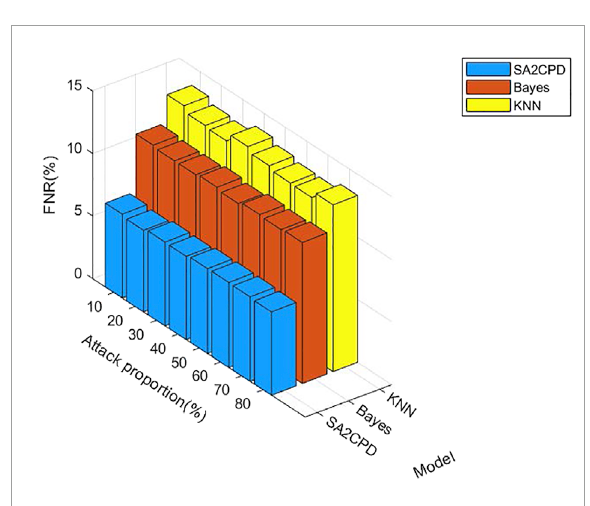
FIGURE 9 The FNR of our SA2CPD model, the Naive Bayes model and the KNN model under different attack proportions.